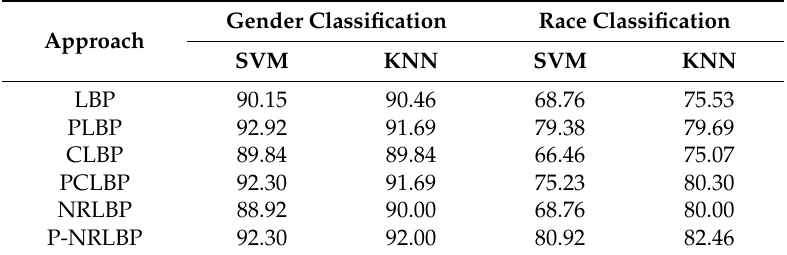
Table 3. Classification Rates for Gender and Race Attributes for YVG (FERET database).